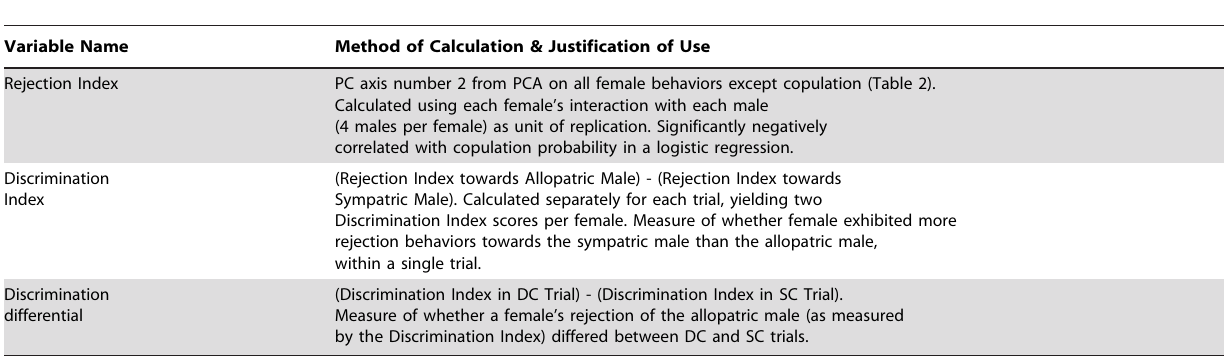
Table 3. Composite variables used in this study, with the methods used to calculate them and explanations of why they were